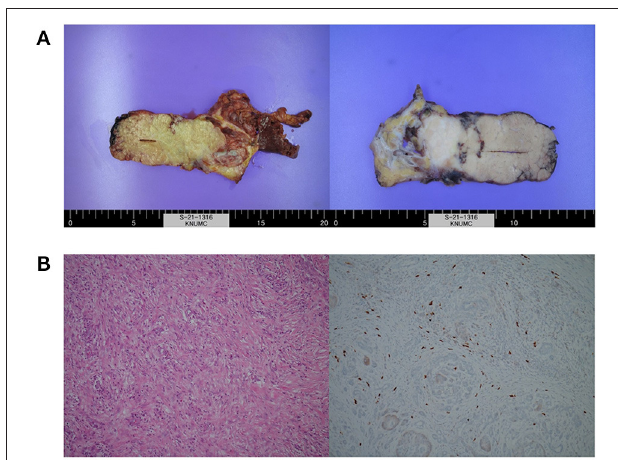
FIGURE 3 | Images of (A) resected surgical specimens and (B) histologic examination showing chronic pancreatitis with storiform fibrosis and infiltration of IgG4-positive